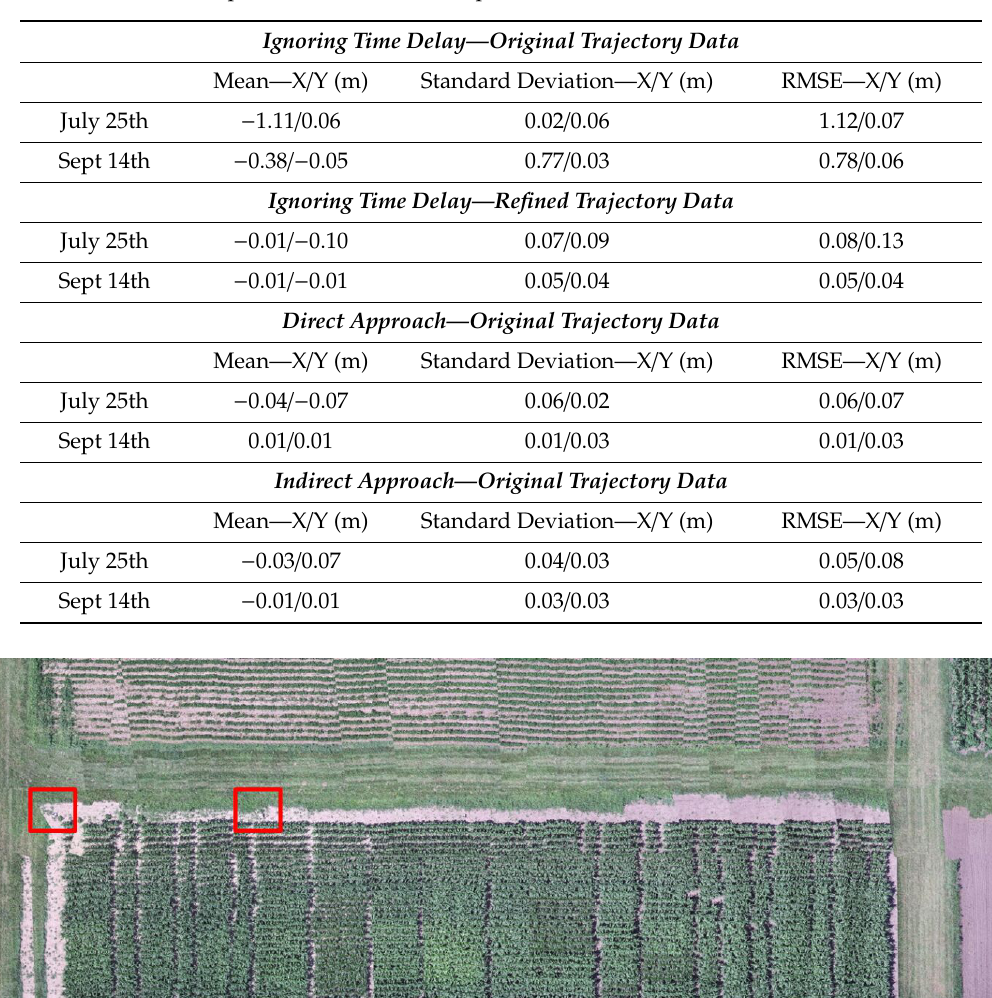
Table 13. Derived statistics of horizontal / planimetric coordinate di ff erences for the five check targets derived from the orthophoto for DJI M200 RGB platform.